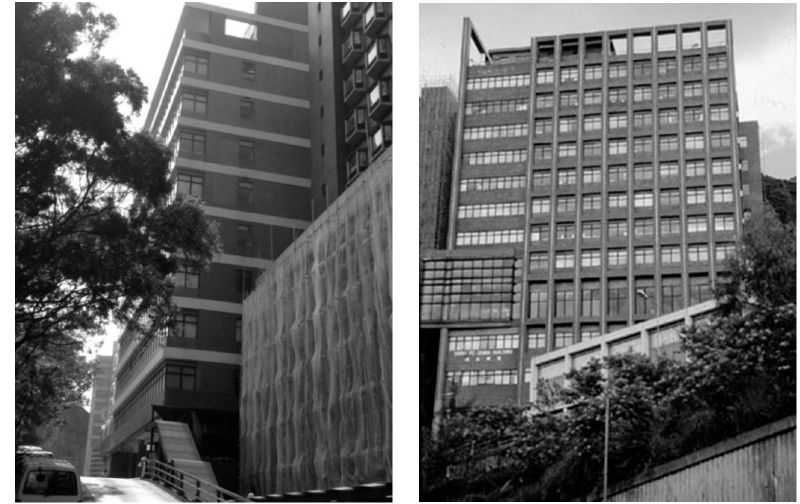
Figure 2. The CYC building: north façades ( left ) and south façades ( right ) (Photo by authors). Table 2. LEED facts for the CYC project (Source: https://www.usgbc.org/projects/hku-chow-yei- ching-building).